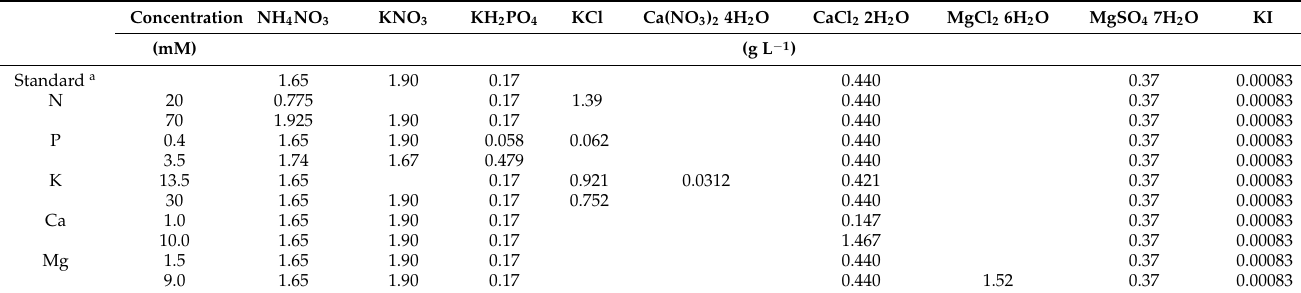
Table 1. Amount of salts that were varied in MS media for propagation of potato plantlets with insufficient and high N, P, K, Ca, and Mg nutrient status for plant nutrient effect